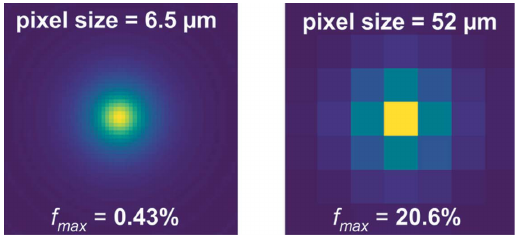
Figure 8 Sharing of the scintillation light over the camera pixels (6.5 and 52 m m) with a 47 m m-thick GOS:Tb screen. The corresponding fraction of scintillation light f max collected by the brightest pixel is also provided.